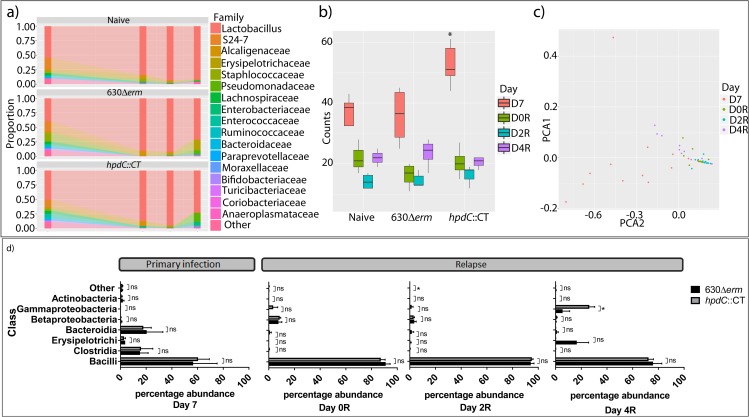
16S relative abundance.The diversity of the intestinal microbiota was assessed using 16S rRNA sequencing to determine the bacterial operational taxonomic units present during a relapse model of C. difficile infection. a) Composition of the intestinal microbiota, at the Family level, between wild type C. difficile 630Δerm and p-cresol mutant (hpdC::CT) infected mice and the naïve control at day 7 post-infection, day 0, day 2 and day 4 post relapse. b) Box and whisker plots displaying the total number of operational taxonomic units (OTUs) at the Family level. Statistically significant differences between the diversity of OTU’s are labelled * p<0.05 (ANOVA). c) Principle component analysis of the microbial diversity at the Family level. Each dot represents a single mouse at a given time point, colour-coded for day 7 post-infection, and days 0, day 2 and day 4 post-relapse. d) The relative prevalence of bacterial Class in wild type C. difficile and hpdC::CT infected mice at day 7 post-infection, day 0, day 2 and day 4 post relapse. Statistical analysis was performed in Stata15 by regression analysis taking strain and bacterial class into consideration * p<0.05.